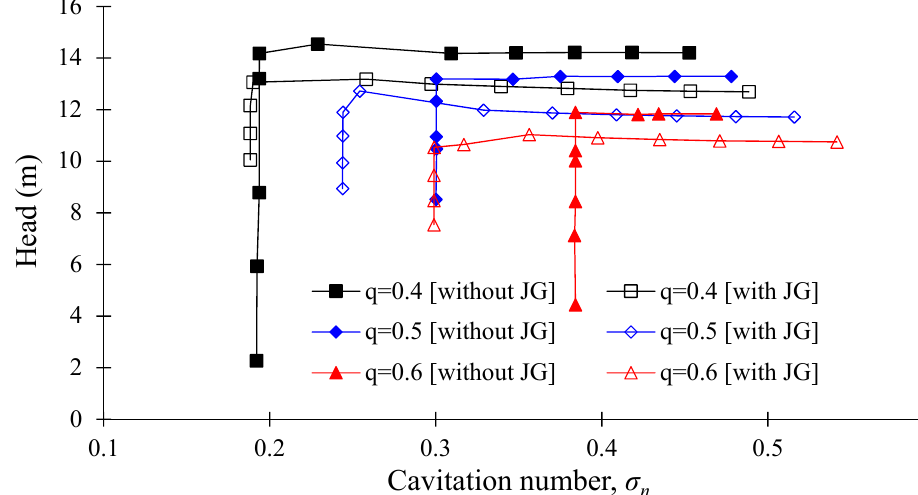
Figure 14. Suction performance comparison in the AJP model without and with J-Groove. The suction performance of the SCP model without and with initial J-Groove is shown in Figure 15. The installation of J-Groove in the SCP model is an effective method to improve the suction performance. The critical cavitation number is improved from 0.08 to 0.05 and 0.12 to 0.09 at 𝑄 𝑄 (cid:3003)(cid:3006)(cid:3017) ⁄ = 0.75 and 1.00, respectively. Furthermore, the signifi- cant improvement at 𝑄 𝑄 (cid:3003)(cid:3006)(cid:3017) ⁄ = 1.15 is indicated in Figure 15. The critical cavitation num- ber is improved from 0.36 to 0.18 at 𝑄 𝑄 (cid:3003)(cid:3006)(cid:3017) ⁄ < 1.15. Hence, the suction of the SCP model is improved considerably with the installation of J-Groove. Figure 15. Suction performance comparison in the SCP model without and with J-Groove. 3.3. Estimation of Reverse Flow Rate by J-Groove Installation The working mechanism of J-Groove is transferring the jet flow from the high-pres- sure region to the low-pressure region via groove passage [27]. The jet flow helps to in- crease the pressure in the low-pressure region. The reverse jet flow is dependent on the pressure difference. The reverse flow rate ratio is the mass flow rate transfer from the J- Groove passage to the best efficiency flow rate for the AJP and SCP models, respectively.